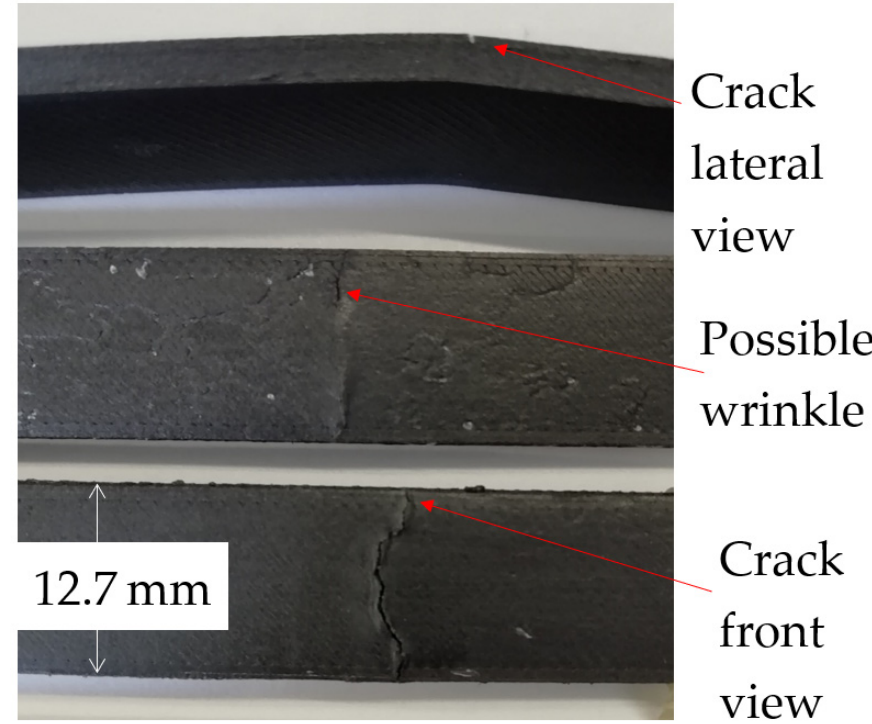
Figure 13. General view of the failure surface.